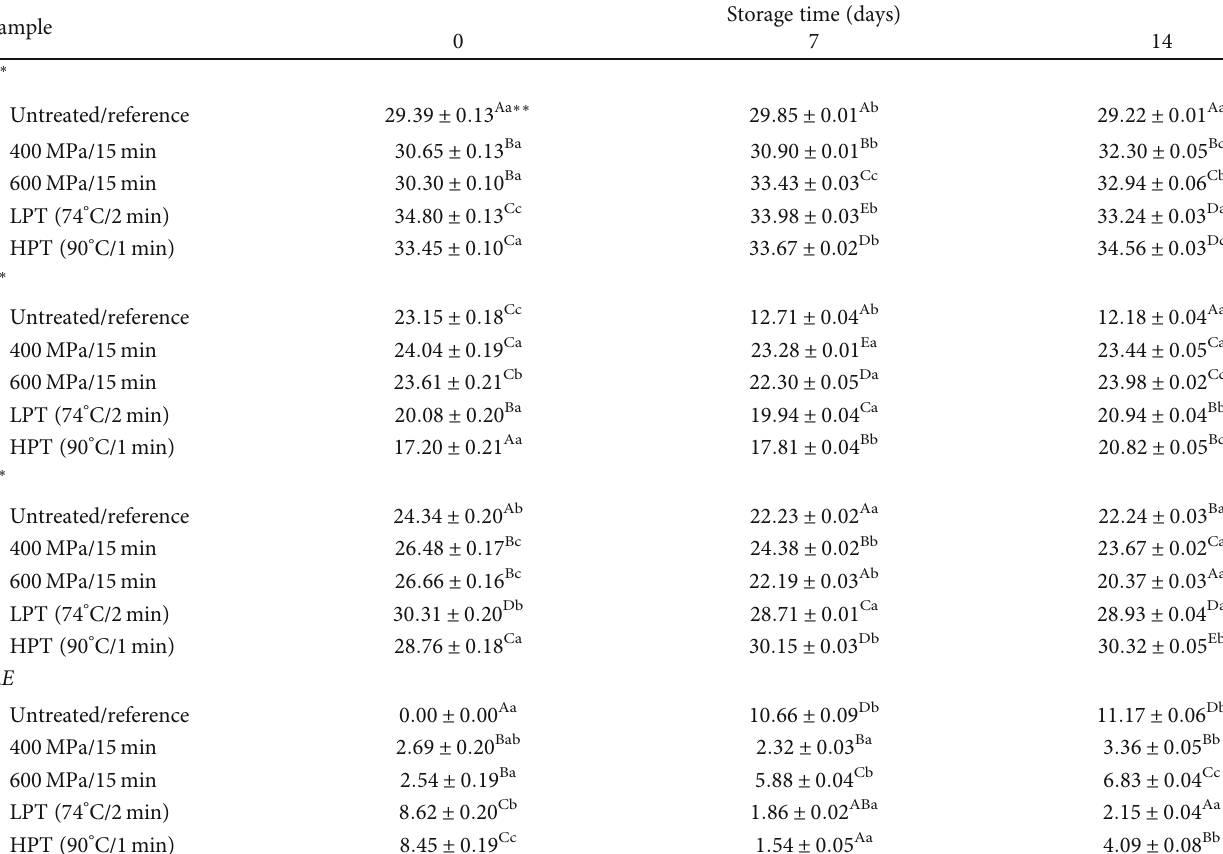
The results are expressed as the mean ± SD , n = 3 . ∗ Three independent measurements: L ∗ (lightness), a ∗ (redness), and b ∗ (yellowness). Δ E is the colour di ff erence between the control and processed tomato juices. ∗∗ Uppercase letters indicate di ff erences between treatment types (in columns) on particular days of storage, whereas lowercase letters indicate di ff erences between storage times for individual samples (in lines) ( p ≤ 0 : 05